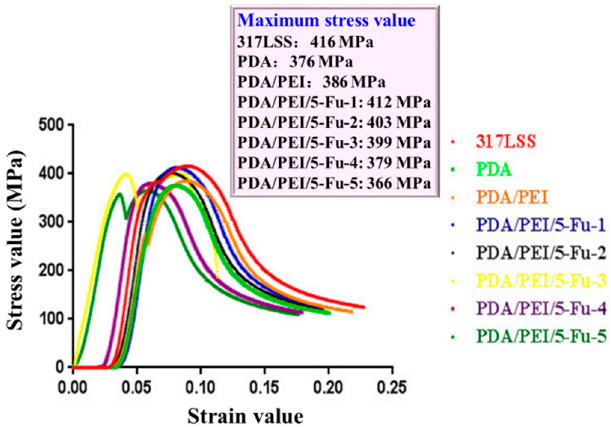
Figure 5. Biomechanical properties of the PDA/PEI/5-Fu-1, PDA/PEI/5-Fu-2, PDA/PEI/5-Fu-3, PDA/PEI/5-Fu-4, PDA/PEI/5-Fu-5, PDA/PEI, PDA and 317L SS surfaces.